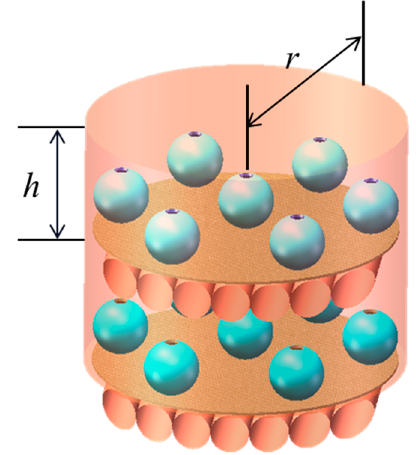
Figure 3. The double-negative acoustic metamaterial: The schematic diagram of the